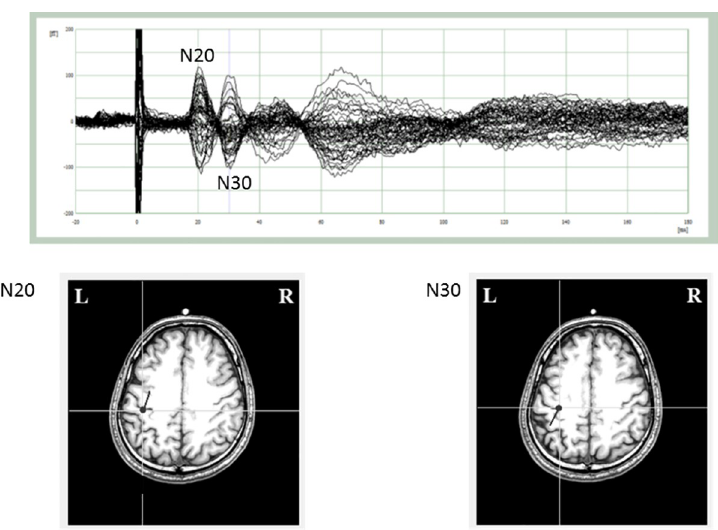
Fig 2. Somatosensory evoked magnetic fields (SEFs) of a representative participant following right median nerve stimulation during hand movement observation. (A) A waveform obtained from several MEG sensors in the primary somatosensory cortex (SI). Two main components, N20 m and N30 m were identified. (B) Localization and direction of the equivalent current dipoles (ECDs) for each SEF component on the magnetic resonance (MR) images. The N20 ECD was located in the posterior bank of the central sulcus in the hemisphere contralateral to the stimulated side, while the N30 ECD was located in the anterior bank of the central sulcus in the hemisphere contralateral to the stimulated side.